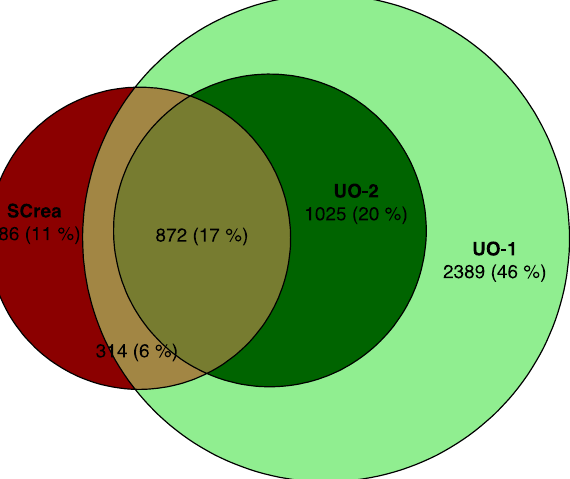
Figure 1. Euler diagram illustrating the distribution and overlap between AKI diagnosis according to different AKI criteria. Numbers indicate the number of patients in that overlap zone, so who would be diagnosed by different criteria. SCrea: serum creatinine > 4.0 mg/dl or > 2 × baseline, where baseline = SCrea-1 whenever available, otherwise SCrea-2, or SCrea-3 (when neither SCrea-1 nor SCrea-2 are available) with Screa-1 defined as baseline Screa measurement as manually entered in ICIS by the treating physician at ICU admission; Screa-2 defined as the lowest pre-ICU measurement up to 365 days before ICU admission as extracted from the lab information system; Screa-3 defined as a back-calculated baseline Screa using the simplified 4-variable Modification of Diet in Renal Disease (MDRD) Study equation assuming an estimated glomerular filtration rate (eGFR) of 75 ml/min/1.73 m 2 for every patient 30 ; UO-1: total UO during the last 12-h period was ≤ 6 ml/kg; UO-2: total UO during each of the last 12 consecutive 1-h periods was ≤ 0.5